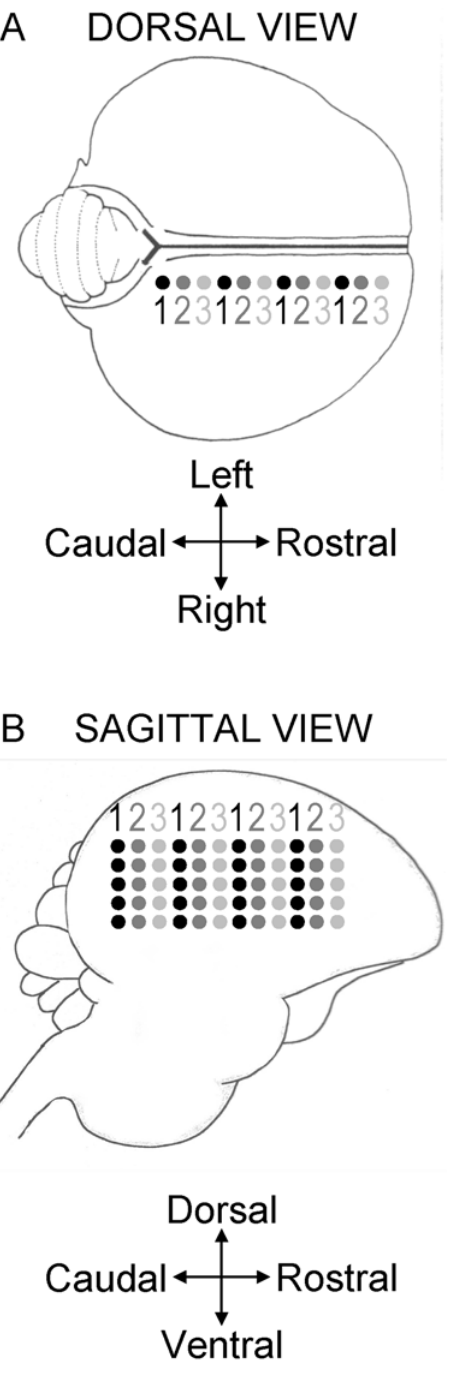
Figure 6. Schematic representation of the positions of the penetration and recording sites in one hemisphere (not to scale). The numbers below and above the dots indicate the recording sessions. A: Dorsal view. Black and grey dots indicate the penetration sites. B: Sagittal view. Black and grey dots indicate the recording sites. Modified from [64].